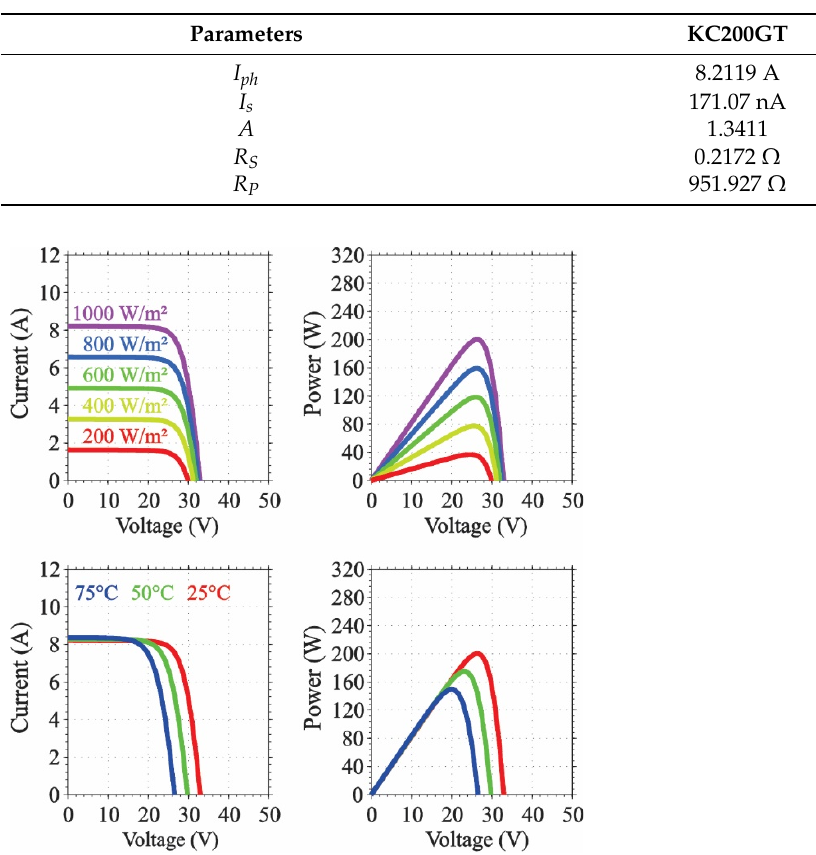
Table 2. One-diode model parameters related to the PV module KC200GT.